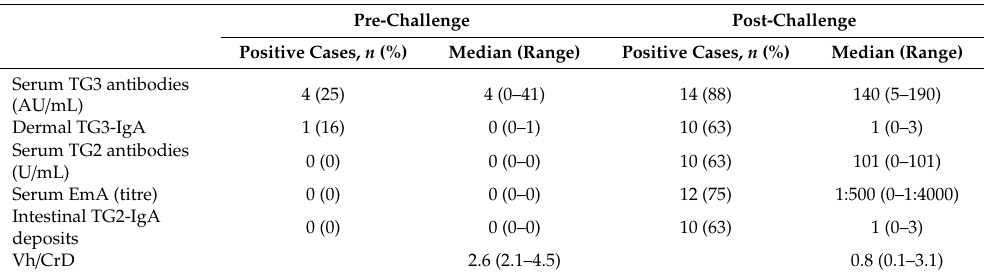
Table 2. Serological, skin, and small bowel mucosal biopsy findings in 16 gluten-challenged dermatitis herpetiformis (DH) patients at pre- and